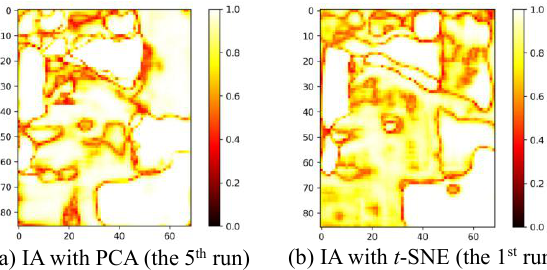
Figure 8 . Predictive maximum probability maps of the presented experiments using the IA data set.